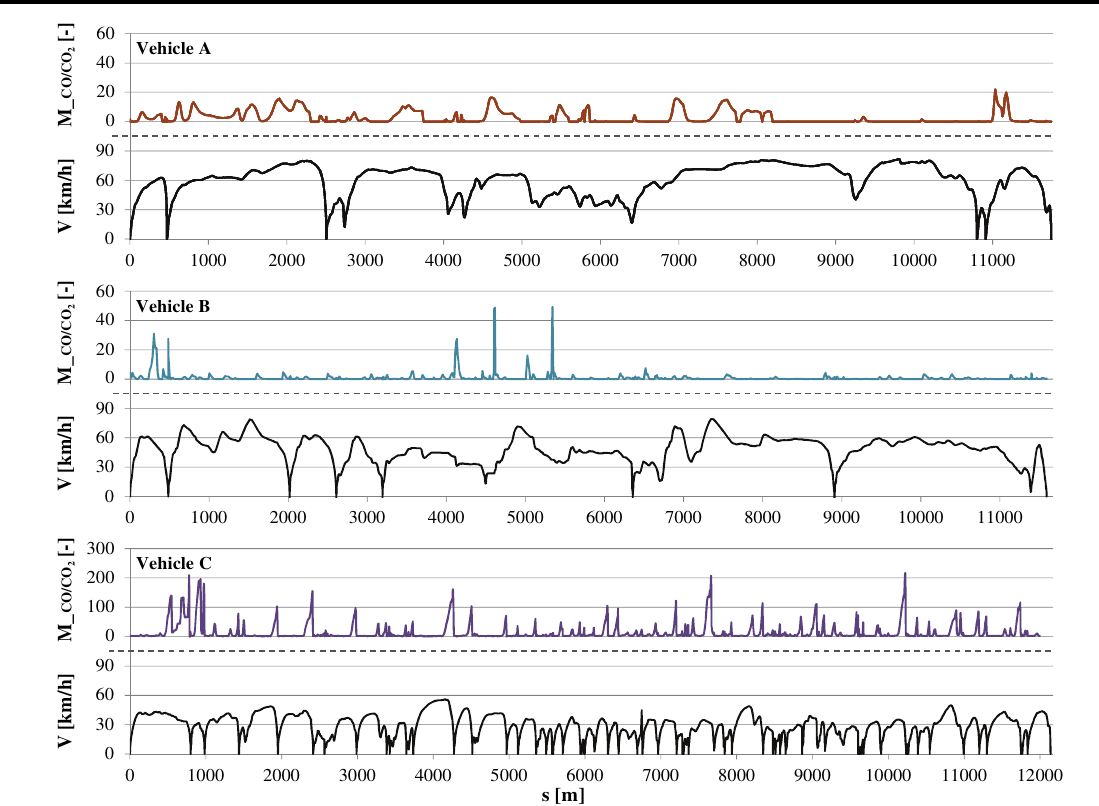
Fig. 8. Vehicle speed curves and the M index for the CO emission values recorded during road tests